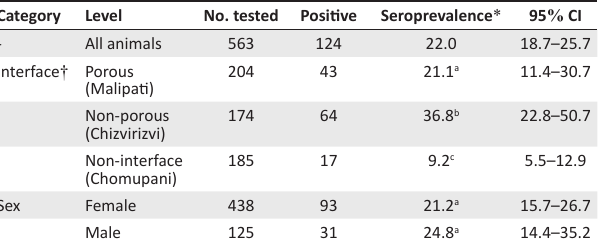
TABLE 1: Distribution of chlamydiosis seroprevalence according to interface and sex. Category Level